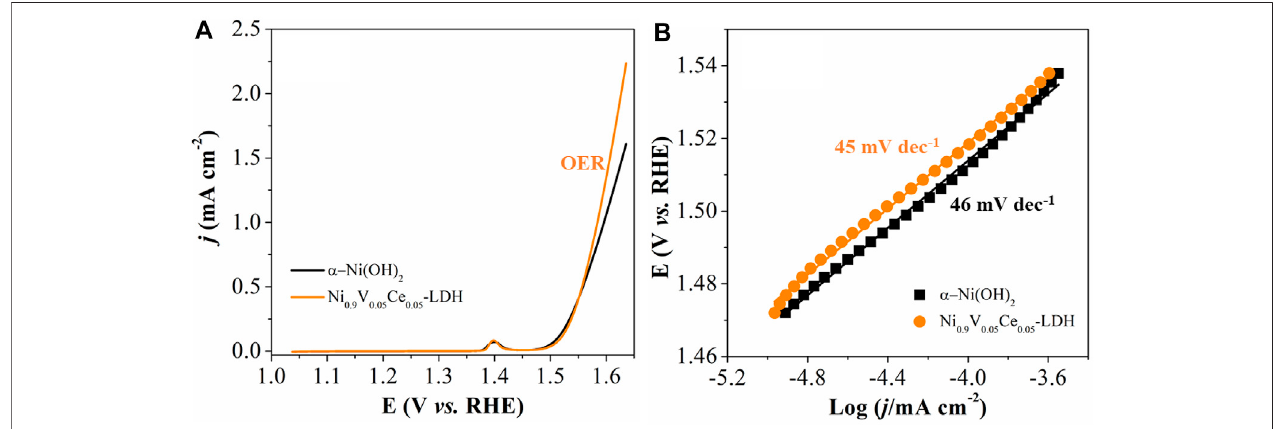
FIGURE 6 | (A) LSV polarization curves at v (cid:2) 5 mV s − 1 after 100 CV cycles, in 1.0 mol L − 1 KOH solution and corresponding (same color) Tafel plots (B) for α -Ni(OH) 2 and Ni 0.9 V 0.05 Ce 0.05 -LDH.